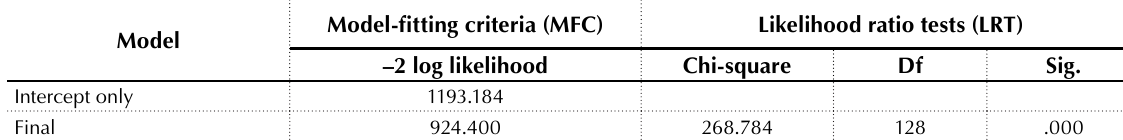
Table 4C. Pseudo R-square